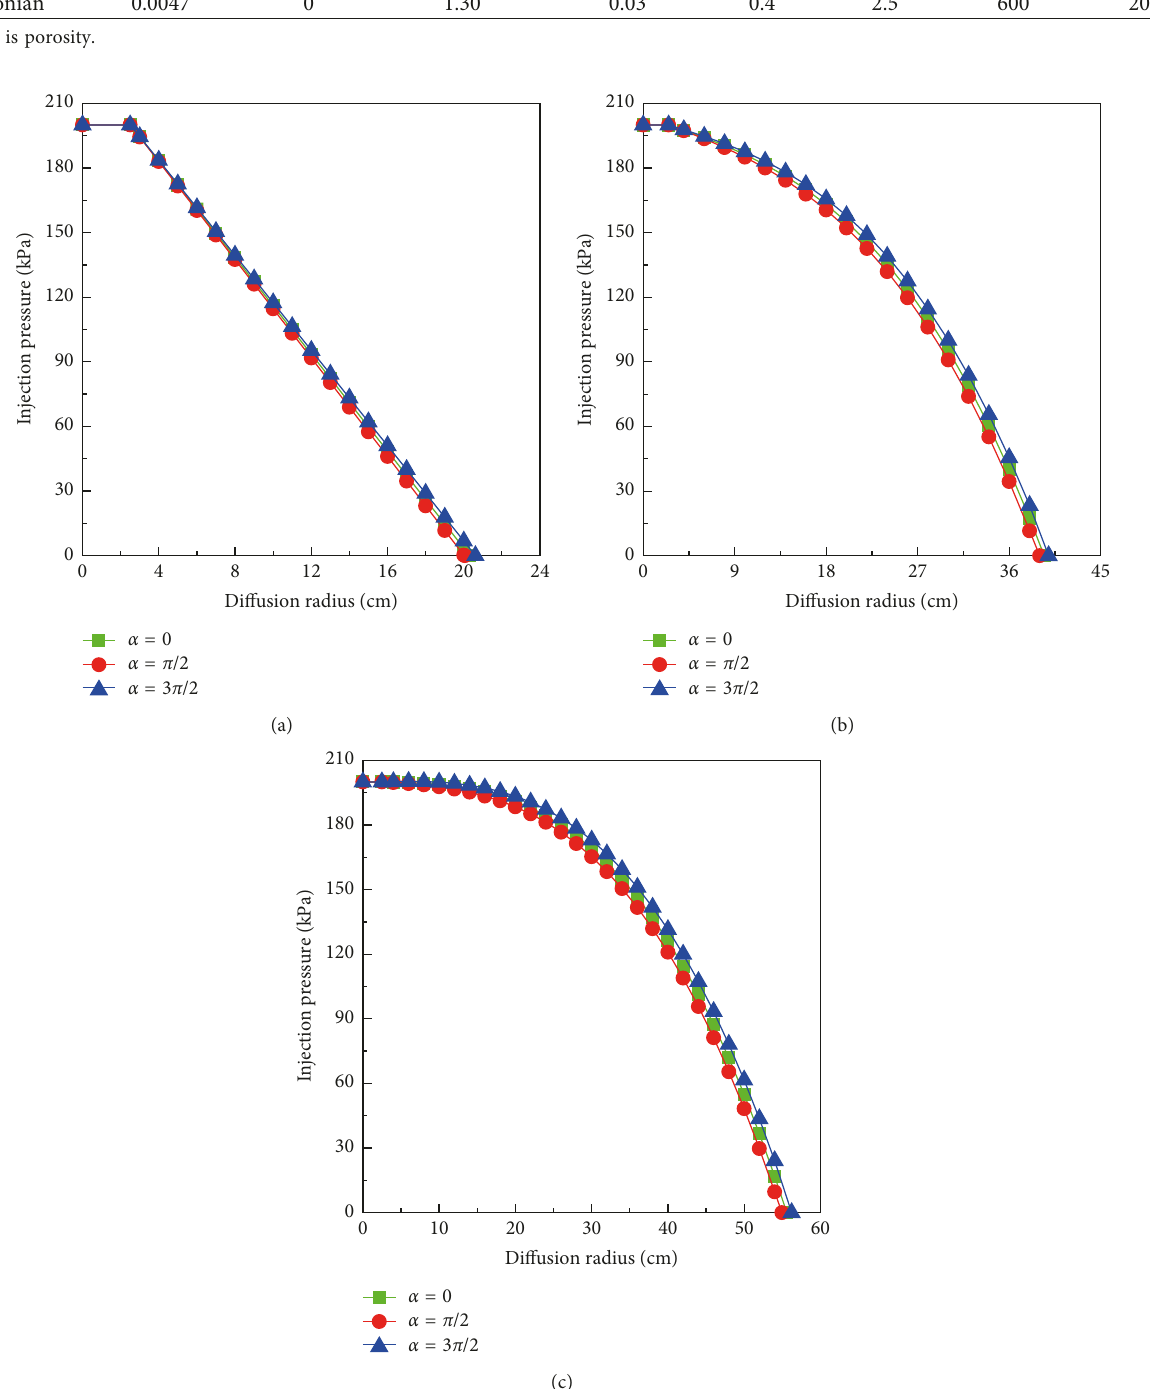
Figure 3: Injection pressure distribution of grouts at different directions. (a) Power-law grout, (b) Bingham grout, and (c) Newtonian